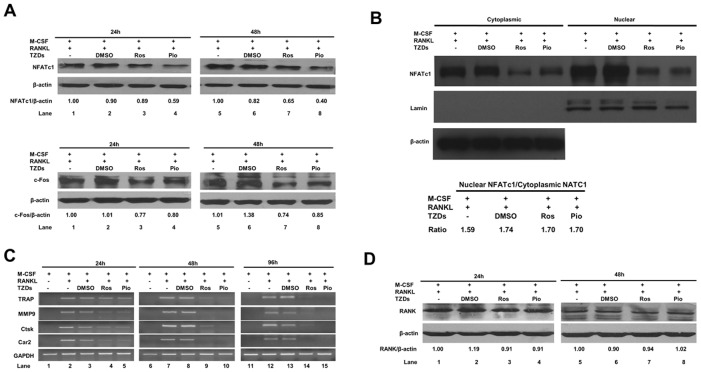
Rosiglitazone and pioglitazone repress RANKL-induced expression of NFATc1, c-Fos, TRAP, MMP9, Ctsk and Car2 genes but exert no effects on RANK expression.(A) BMMs were treated with M-CSF (44 ng/ml) and RANKL (100 ng/ml), M-CSF (44 ng/ml) and RANKL (100 ng/ml) plus DMSO or 40 µM rosiglitazone (Ros) or pioglitazone (Pio) for 24 hours (h), 48 h prior to lysis for Western blot assays with antibodies against NFATc1 (top panel) or c-Fos (bottom panel). The blots were stripped and then re-probed with β-actin antibody for loading control. Ratios of NFATc1/c-Fos to β-actin were obtained by dividing the densitometric reading of NFATc1/c-Fos with that of β-actin, and then the value calculated for the assay treated with M-CSF (44 ng/ml) and RANKL (100 ng/ml) was set as 1.00. The assays were repeated three times. One representative set of experiments is shown. (B) BMMs were treated with M-CSF (44 ng/ml) and RANKL (100 ng/ml), M-CSF (44 ng/ml) and RANKL (100 ng/ml) plus DMSO or 40 µM Ros or Pio for 48 h, and then cytoplasmic and nuclear extracts were prepared from the cells for Western analysis of NFATc1 expression. Lamin A/C was used to determine the quality of the cytoplasmic and nuclear extracts and also used as loading control for nuclear extract samples. β-actin was used as loading control for cytoplasmic extract samples. Densitometric values of cytoplasmic NFATc1 were normalized by β-actin densitometric values, whereas densitometric values of nuclear NFATc1 were normalized by those of lamin A/C. Ratios of nuclear NFATc1 to cytoplasmic NFATc1 were obtained by dividing normalized densitometric values of nuclear NFATc1 with normalized densitometric values of cytoplasmic NFATc1. The assays were repeated two times and one set of data is shown. (C) BMMs were treated with M-CSF (44 ng/ml), M-CSF (44 ng/ml) and RANKL (100 ng/ml), M-CSF (44 ng/ml) and RANKL (100 ng/ml) plus DMSO, or 40 µM Ros/Pio for 24 h, 48 h and 96 h prior to isolation of total RNAs for semi-quantitative RT-PCR analysis. The assays were repeated three times. One representative set of experiments is shown. (D) BMMs were treated with M-CSF (44 ng/ml) and RANKL (100 ng/ml), M-CSF (44 ng/ml) and RANKL (100 ng/ml) plus DMSO or 40 µM Ros/Pio for 24 h, 48 h prior to lysis for Western blot assays with an antibody against RANK. The blots were stripped and then re-probed with β-actin antibody for loading control. Ratios of RANK to β-actin were obtained by dividing the densitometric reading of RANK with that of β-actin, and then the value calculated for the assay treated with M-CSF (44 ng/ml) and RANKL (100 ng/ml) was set as 1.00. All assays were repeated three times. One representative set of experiments is shown.